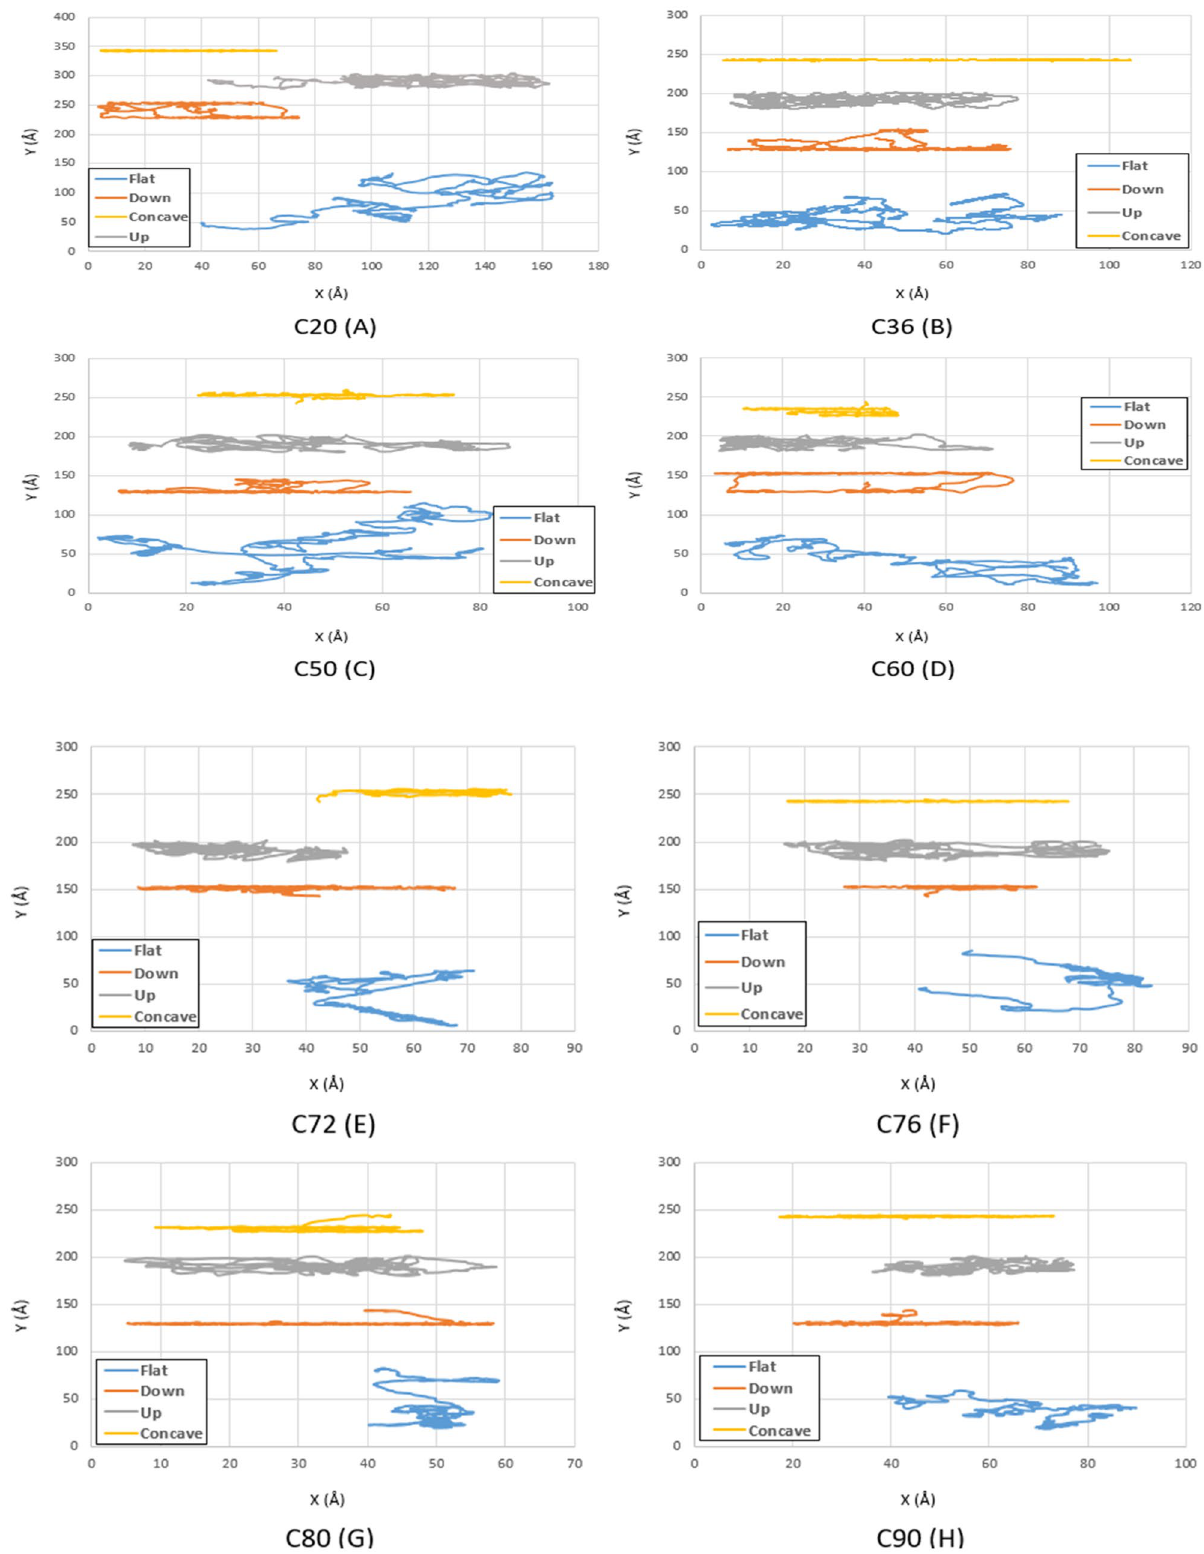
Figure 7. Trajectories of different fullerenes on a gold substrate at 500K for C 20 ( A ), C 36 ( B ), C 50 ( C ), C 60 ( D ), C 72 ( E ), C 76 ( F ), C 80 ( G ), and C 90 ( H ). The blue, red, black and yellow lines show the trajectories of the molecules on the flat, down side of the step, top side of the step, and concave substrates,